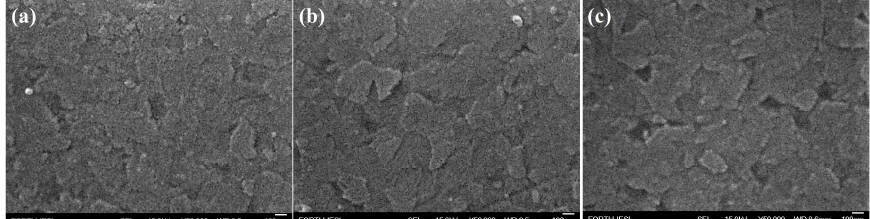
Figure 3. FE-SEM images of the electrodeposited V 2 O 5 for current densities of 0.7 ( a ), 1.0 ( b ), and 1.3 mA ∙ cm − 2 ( c ) at a constant electrolyte concentration of 0.5 M for a magnification of ×50,000.